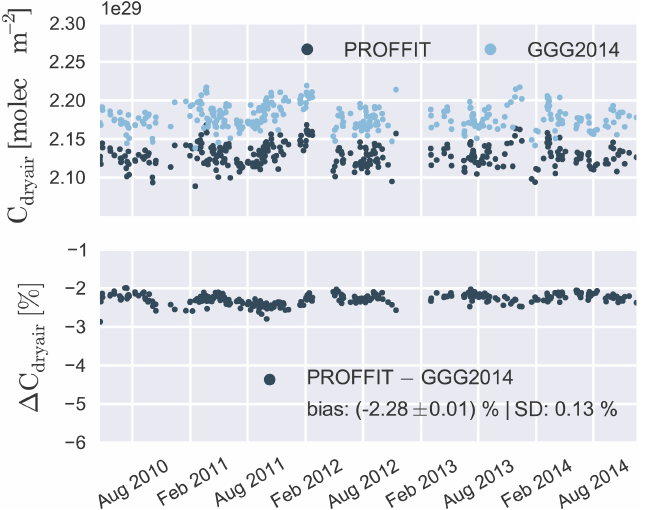
Figure A2. Retrieved total columns of dry air using Eq. (2) (GGG2014) and Eq. (3) (PROFFIT) are shown in the upper panel. The lower panel shows the relative